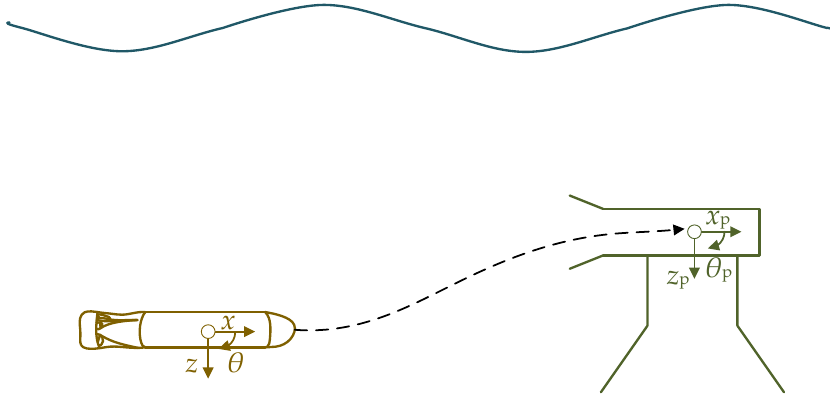
Figure 1. Diagram of the docking of an AUV onto a moving platform in surge, heave and